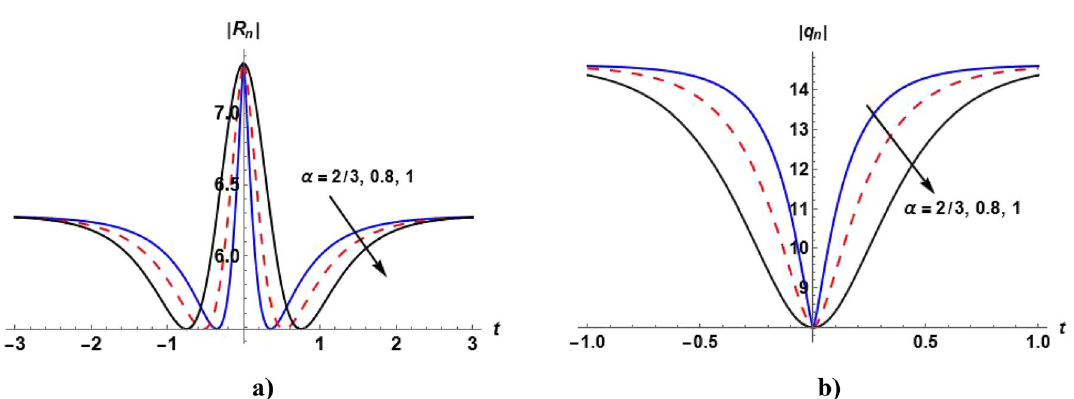
Figure 4. Plot of the solutions (32) and (33) when c 1 values of n for different values of α .